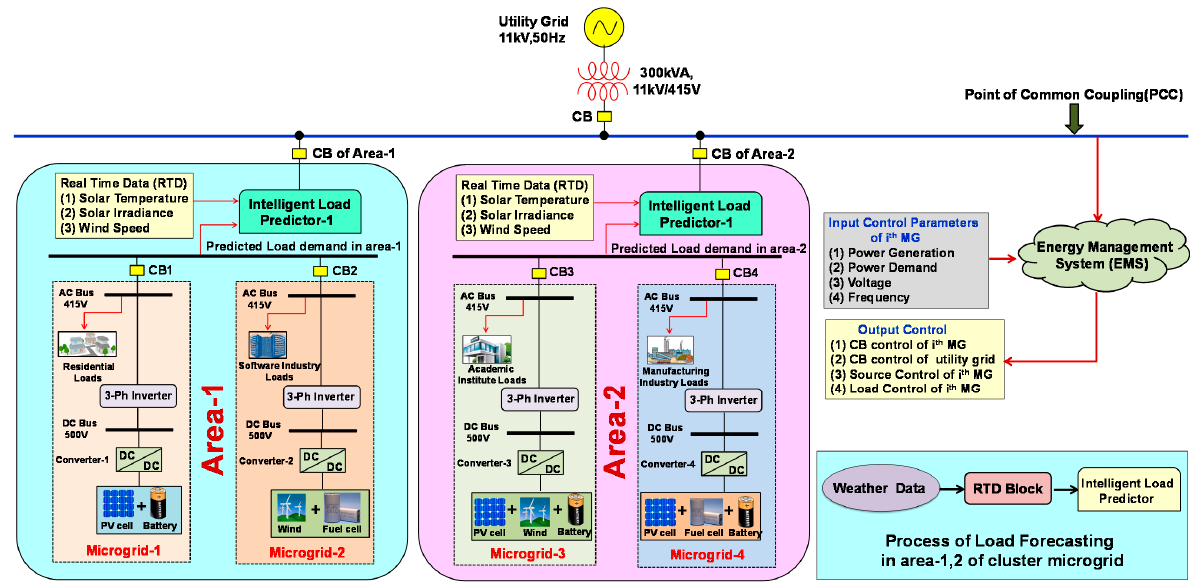
Figure 1. The architecture of cluster microgrid (single line diagram). Table 1. Typical values of components used in the proposed system [29].